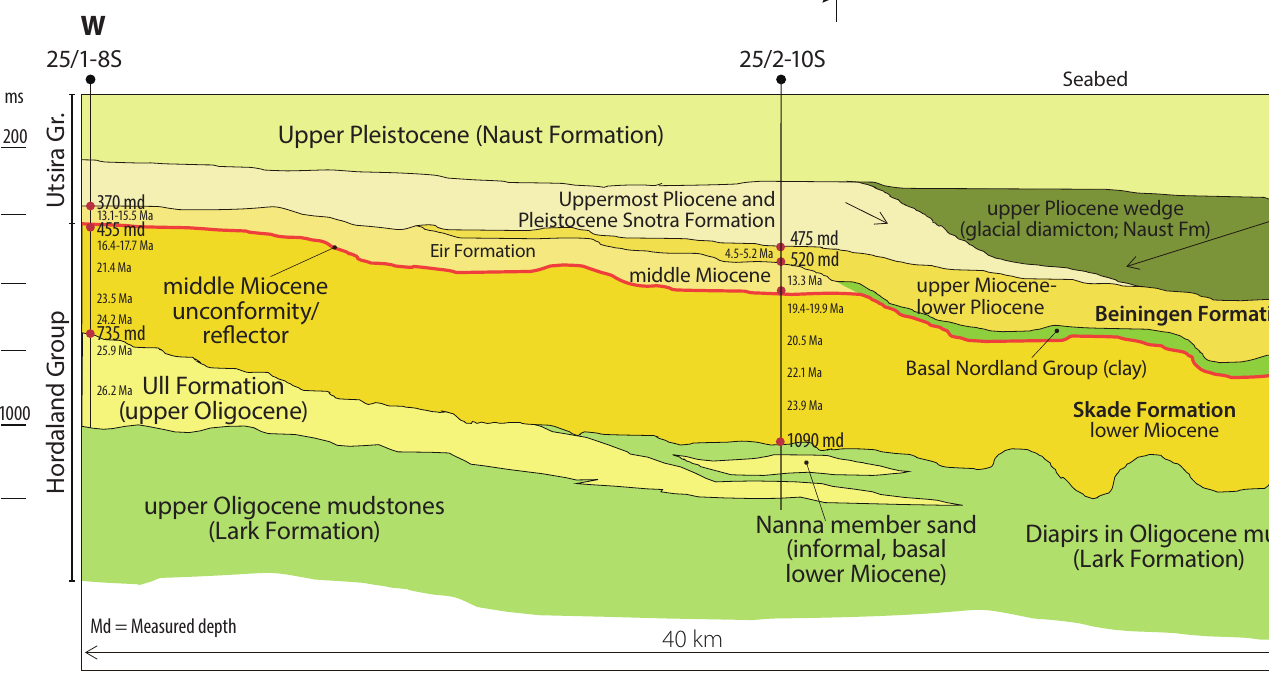
Figure 23. Geo-section showing how four different delta sands, which constitute the outer delta front of the Hutton sand system (informal name used only in UK waters), are deposited in the Frigg Field area. In Norwegian waters the lower Miocene Skade Formation is turbiditic in origin and overlies upper Oligocene sand (Ull Formation) and upper Oligocene mudstones (Lark Formation). The Beiningen Formation of the Utsira Group overlies distal middle Miocene mudstones of the Nordland Group towards the east and middle Miocene sandy deposits of the Eir Formation towards the west. The middle Miocene thins out farther west towards the 25/1–8 S area. An uppermost Pleistocene delta (Snotra Formation) is built out on top of the Beiningen Formation in the 25/2–10 S area (see Fig. 2 for location; modified after Gjeldvik et al., 2011; Eidvin et al., 2013d). The main ages obtained from the strontium isotope analyses in well 25/1–8 S and 25/2–10 S after Eidvin et al. (2013d, 2019) are also